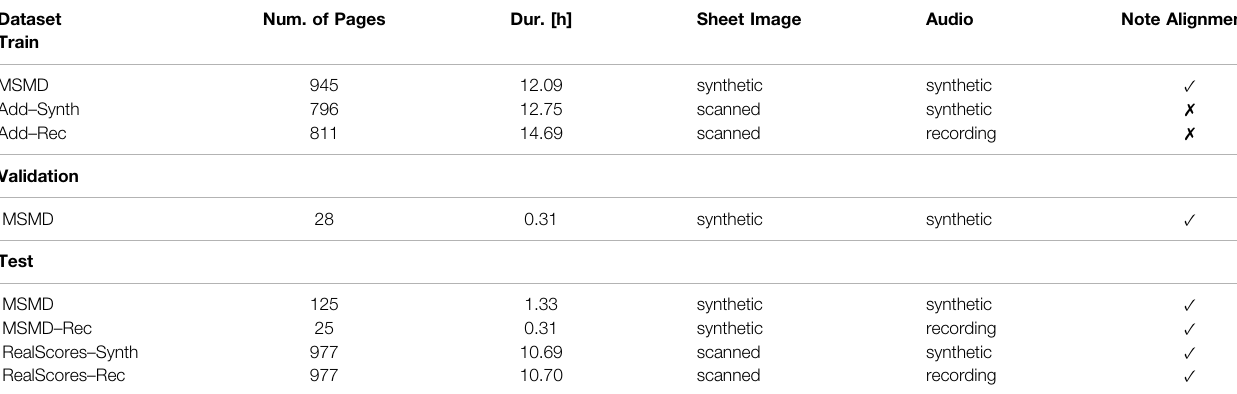
TABLE 3 | Overview of datasets used for training, validation and